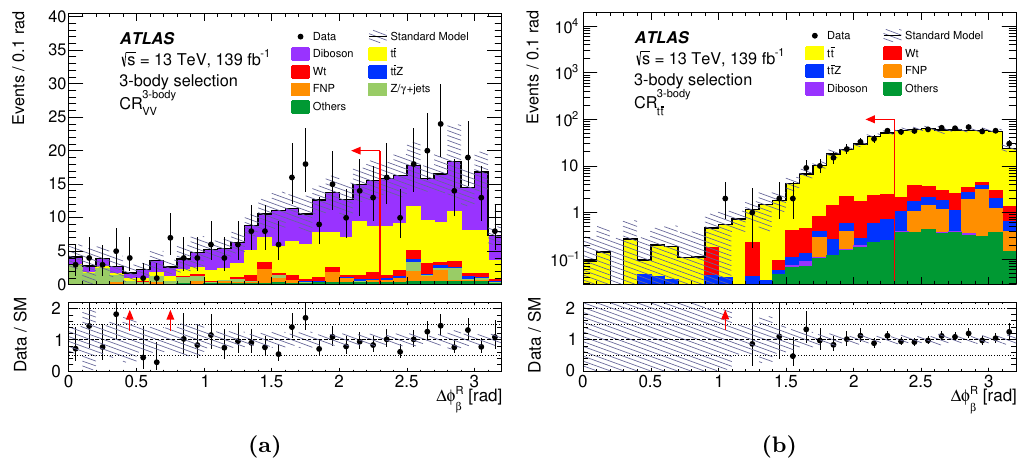
in the CR 3-body selection, and (b) in β V V